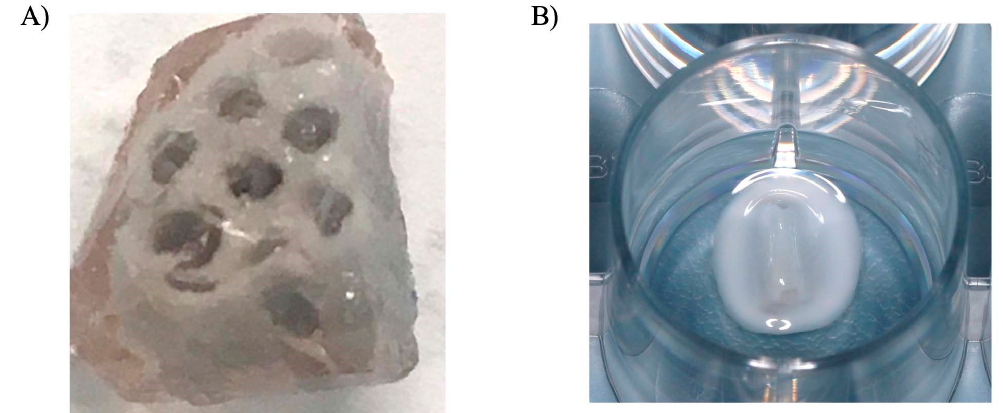
Figure 7. ( A ) Representative image showing the Calcium Phosphate porous block infused with the Gtn–HPA hydrogel (Pore size ~900 µm). ( B ) Image showing the Gtn–HPA infused block in a cell culture well for a migration assay surrounded by the MSC-seeded collagen ring.